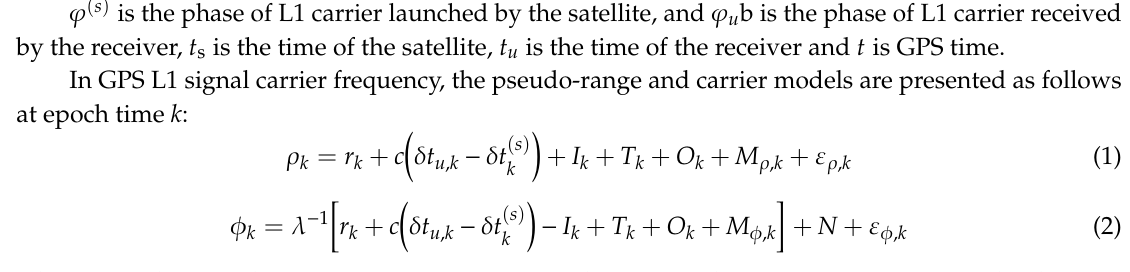
Figure 2. Schematic of the principle of the carrier-smoothed pseudo-range.